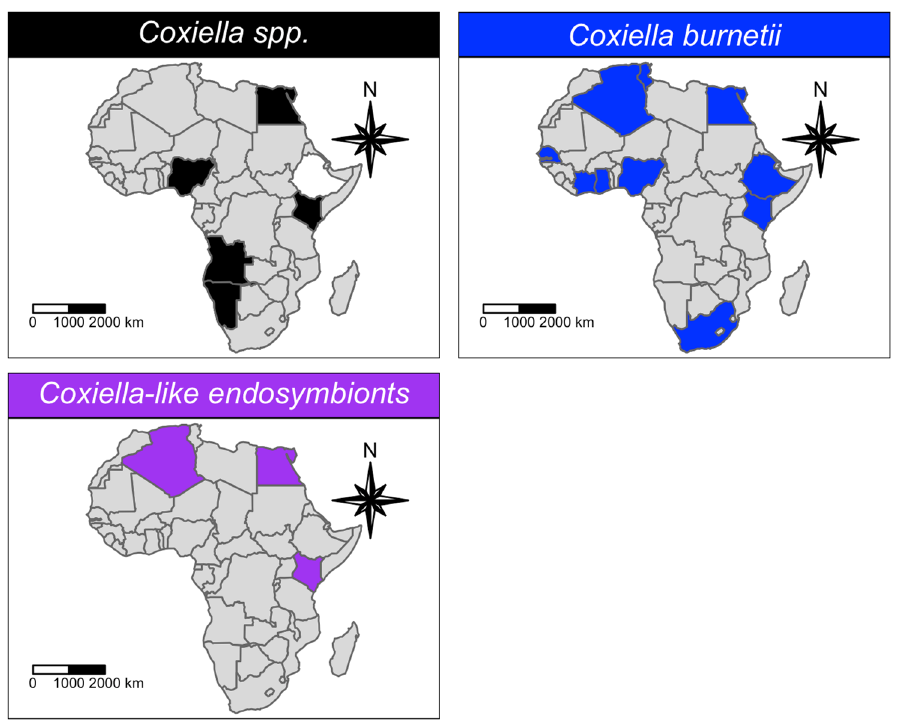
Figure 7. Geographic distribution of Coxiellaceae species detected in African ticks. Countries where the pathogen was investigated, but not detected, are represented in white, while countries where the pathogen has not been investigated are represented in grey.